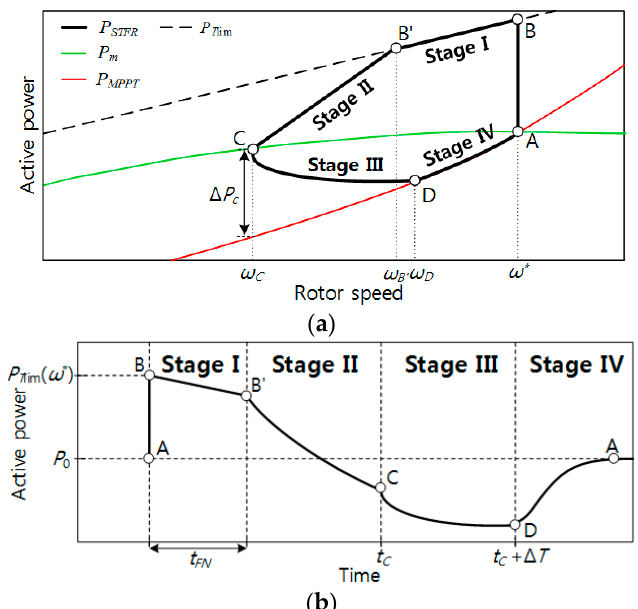
Figure 4. Operational characteristics of the proposed scheme. ( a ) Power-rotor speed trajectory of the proposed scheme; ( b ) P STFR of the proposed scheme. P T lim ( ω * ): torque limit referred to power at ω *; P STFR : power reference of the proposed scheme; t C : beginning instant of Stage III; t FN : period for Stage I; ω B’ : rotor speed at Point B’.